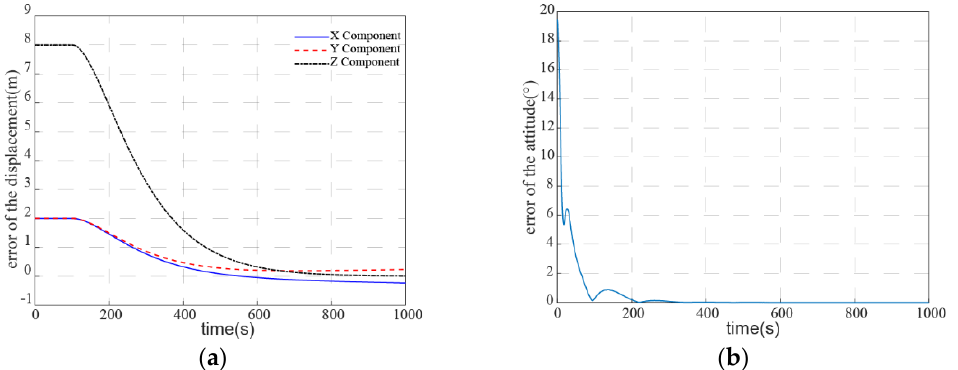
Figure 14. ( a ) The distance between the flexible lander and the target; ( b ) the angle between the lander’s normal direction and the target n .